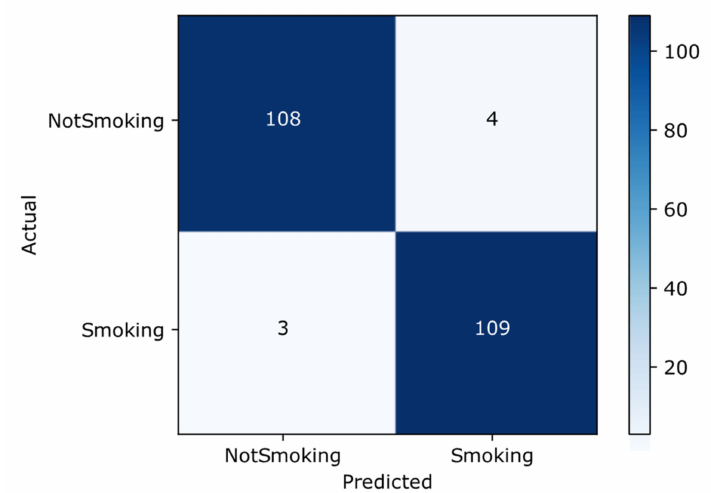
Figure 6. Confusion matrix.